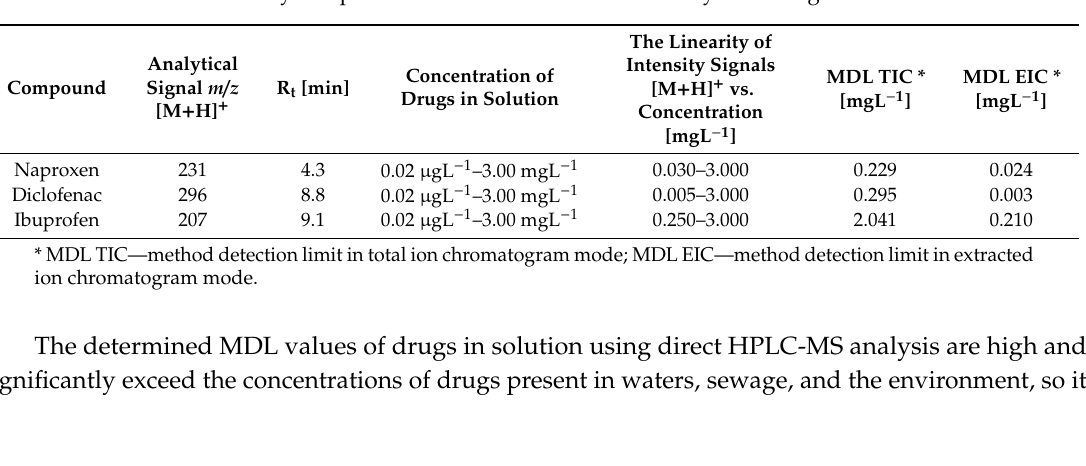
Table 2. Analytical parameters for HPLC-MS in the analysis of drug solutions.